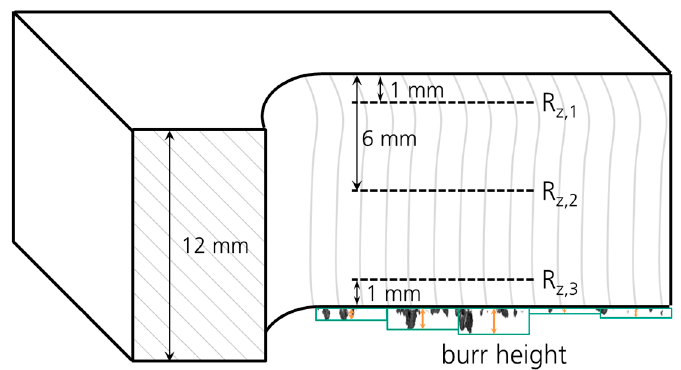
Figure 5. Cross-sectional view along the cutting direction verifies the cut edge quality: maximum burr height was detected in five sections, surface roughness R z was measured along three lines.